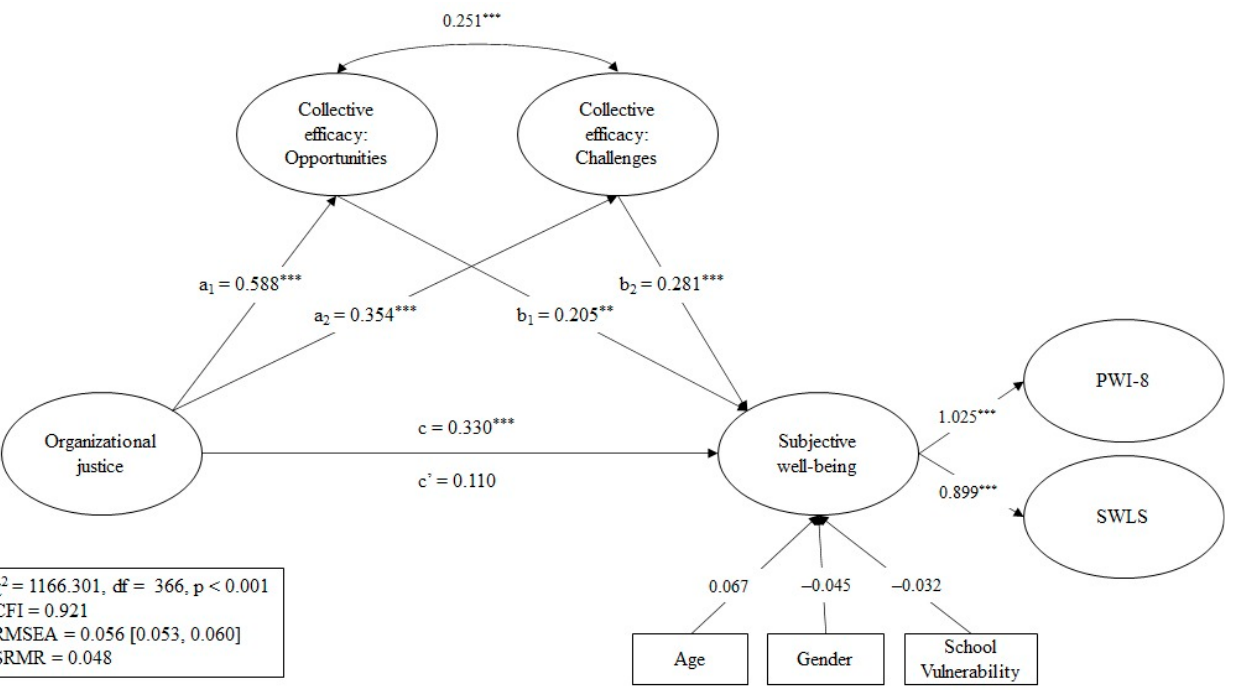
Figure 1. Mediation model using the pooled sample. *** p < 0.001. ** p <